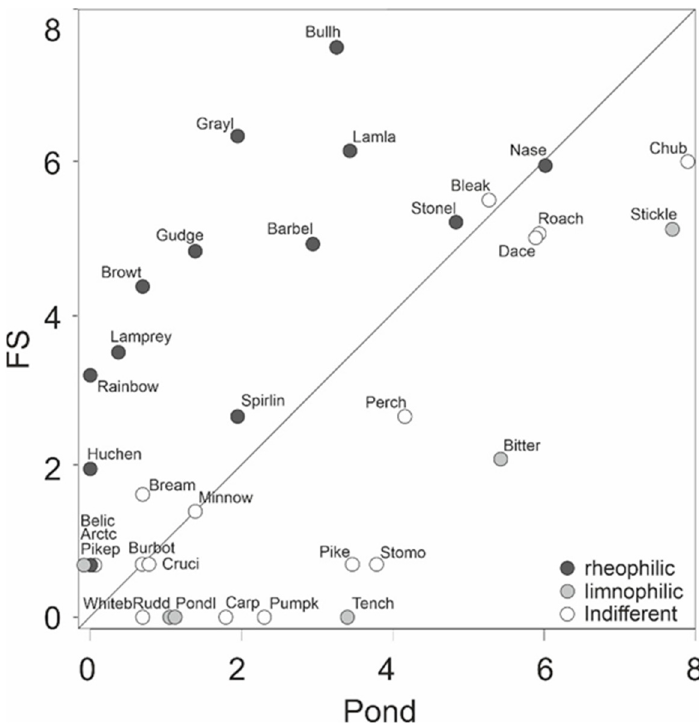
Figure 5. Scatterplot of pooled fish abundance data (based on Log(X + 1) transformed abundance data), distinguishing their primary occurrence in floodplain ponds and fluvial habitats (FS) of the fish passes Gars and Stammham. Shaded symbols indicate the different current preferences of species according to Reference [45]. For abbreviations of species, refer to Table 6.